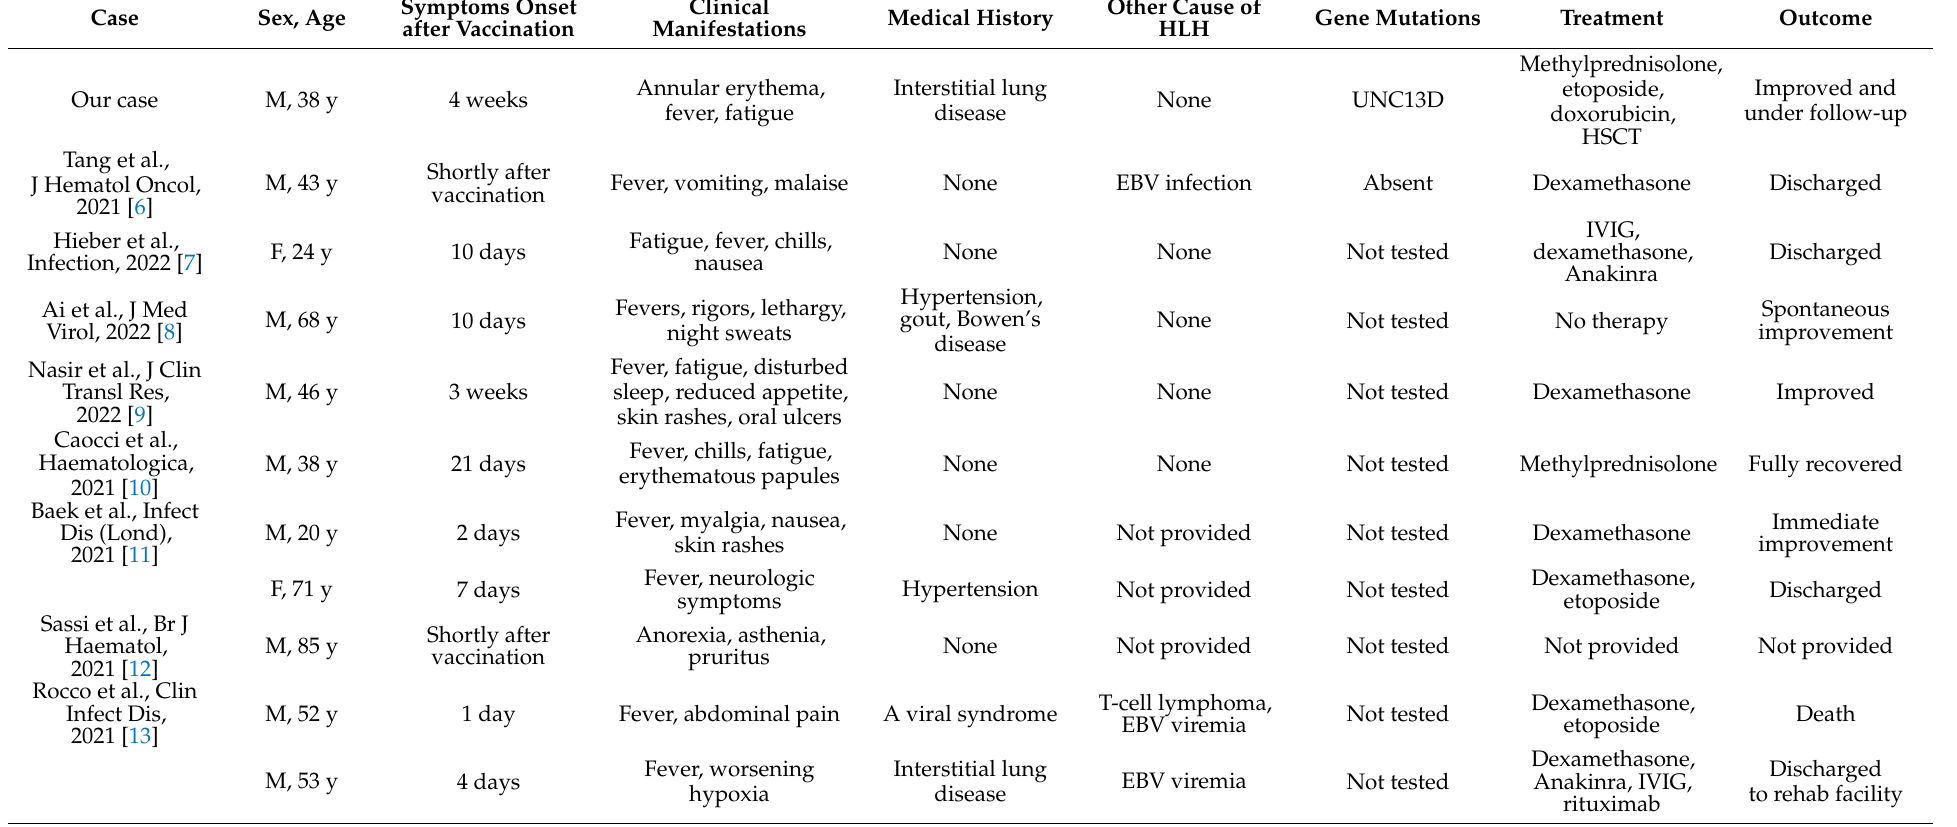
Table 2. Reported cases of HLH following COVID-19